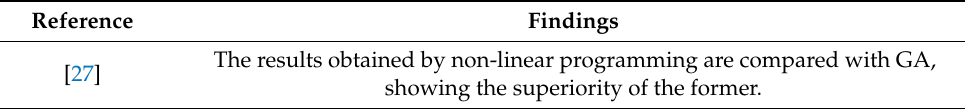
Table 8. Findings of selected papers associated with non-linear